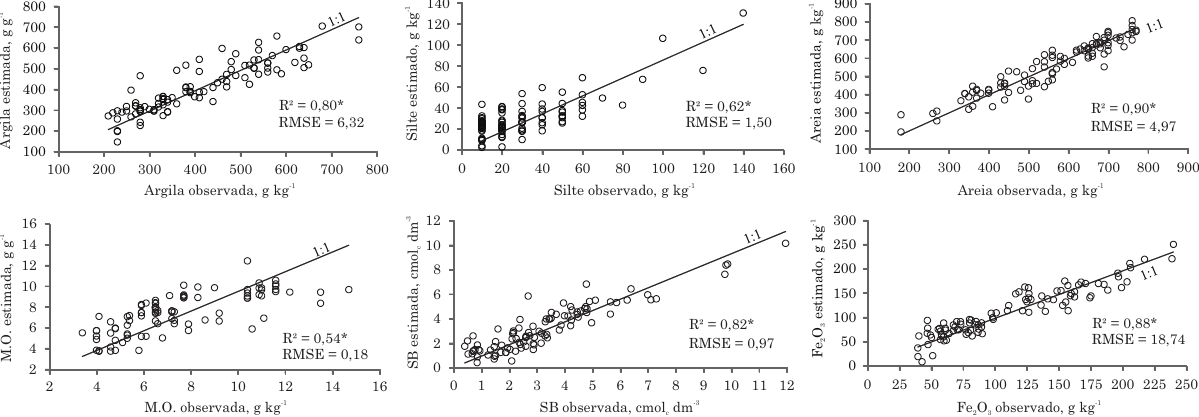
Figura 2. Gráficos de dispersão de valores observados versus estimados para argila, silte, areia, matéria orgânica, soma de bases e ferro total do horizonte subsuperficial. RMSE: raiz quadrada do erro quadrado